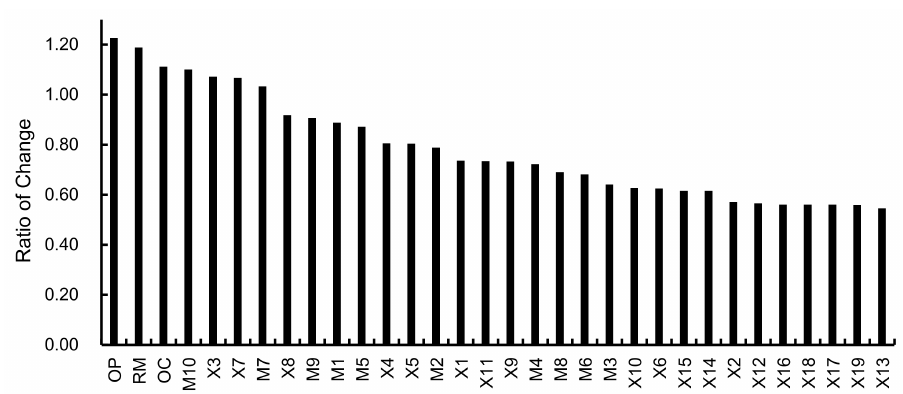
Figure 12. Sensitivity analysis of human factors.